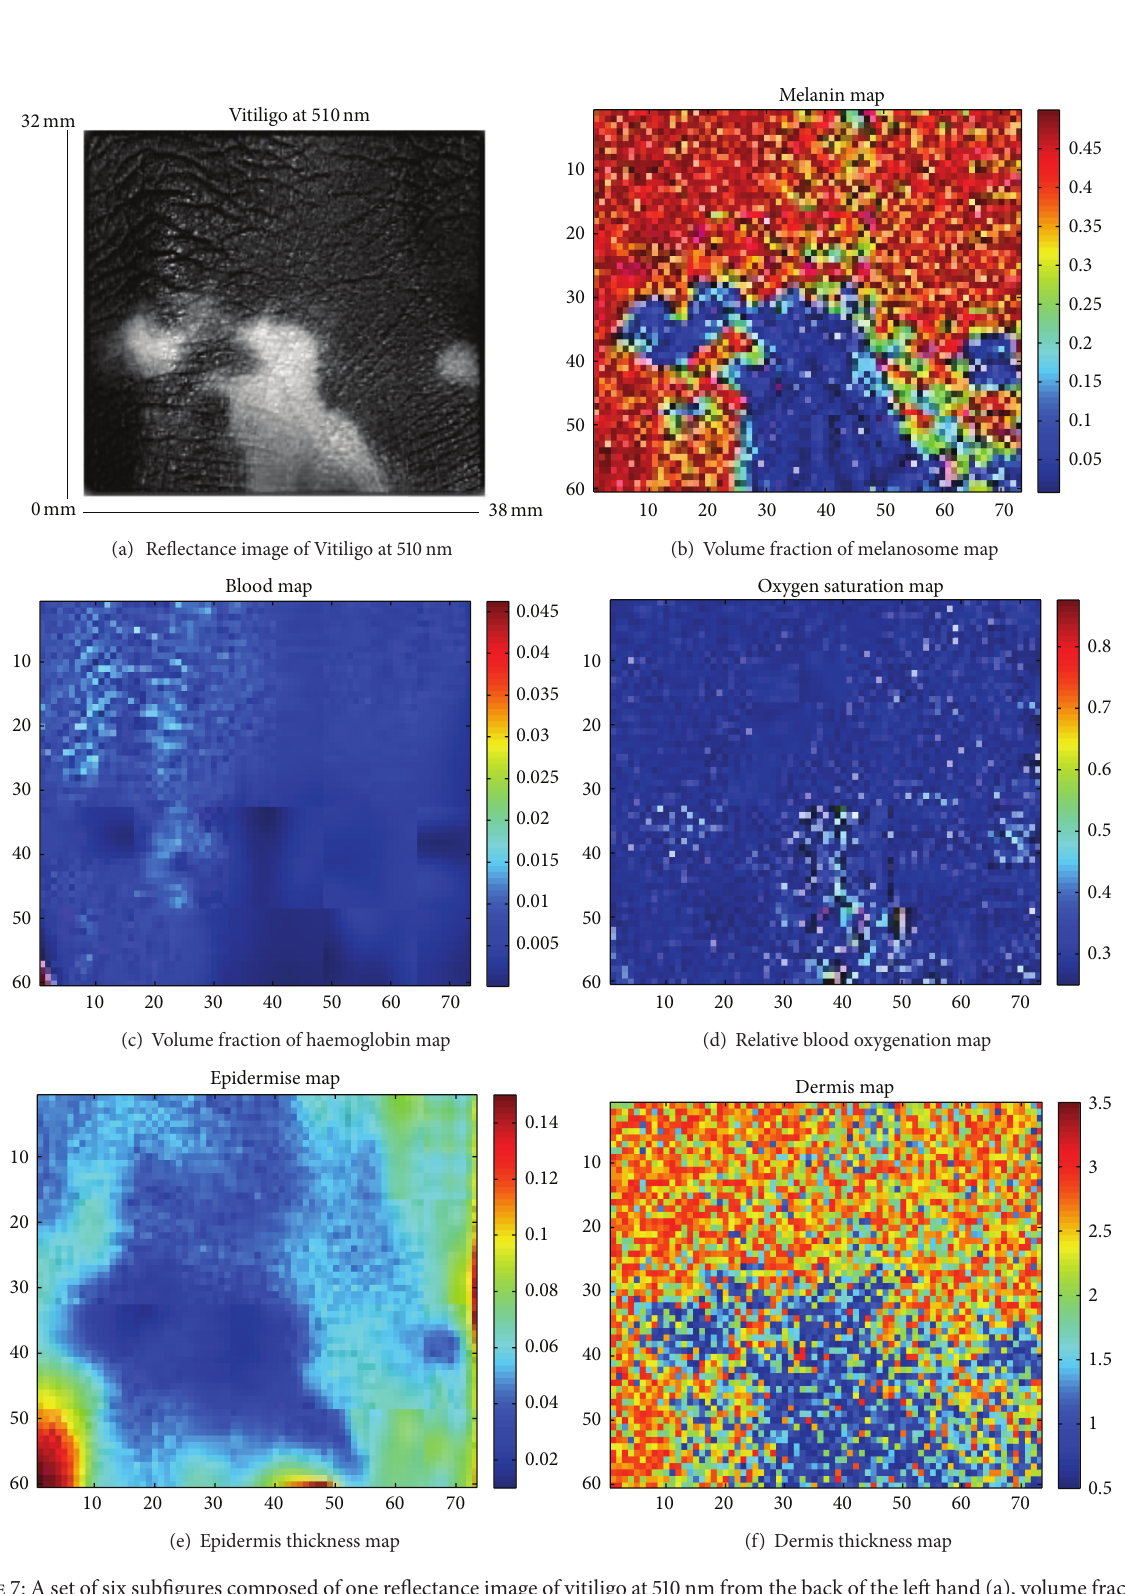
Figure 7: A set of six subfigures composed of one reflectance image of vitiligo at 510 nm from the back of the left hand (a), volume fraction of melanosome map (b), volume fraction of haemoglobin map (c), oxygenated hemoglobin map (d), epidermis thickness map (e) and dermis thickness map (f). The subfigure (a) has been contrast enhanced for better viewing purpose